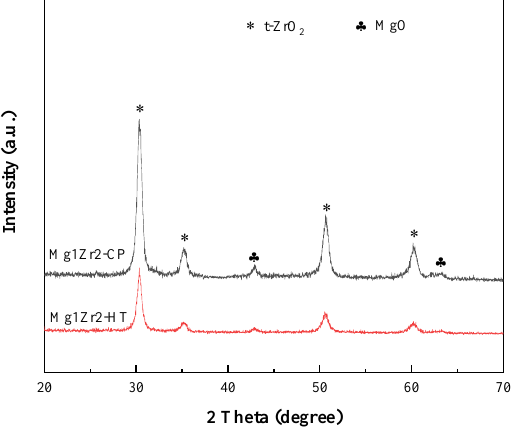
Figure 1. XRD patterns of Mg1Zr2-HT and Mg1Zr2-CP.